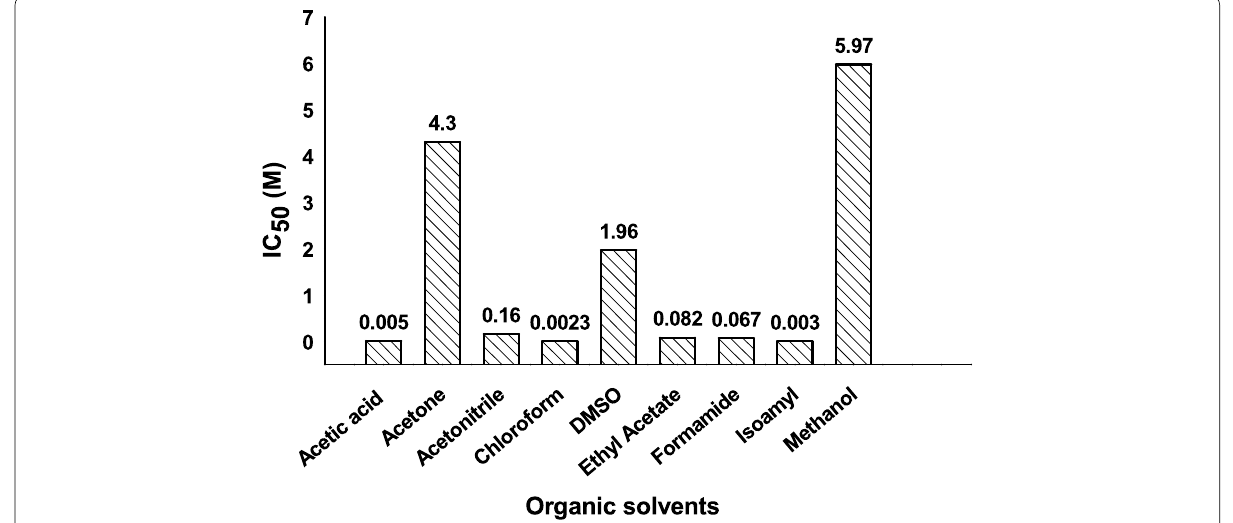
Fig. 8. IC 50 of organic solvents on the bioluminescence of Vibrio sp.